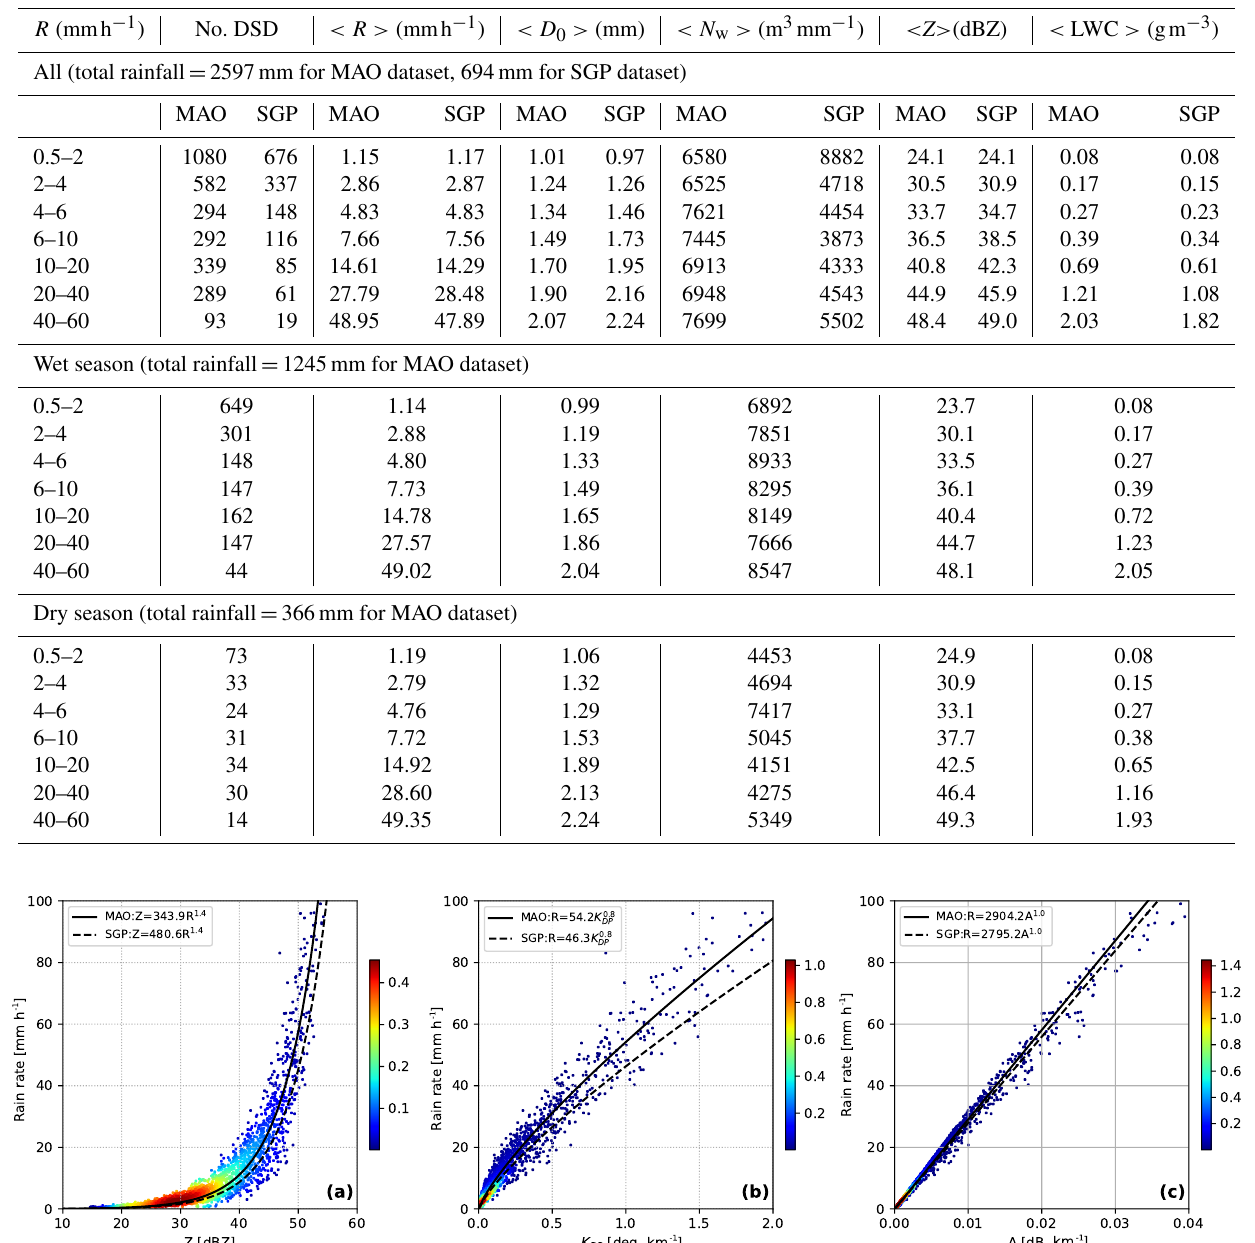
Figure 2. Scatter plots of (a) Z , (b) K DP and (c) A versus rain rate and overlaid associated relationship fits using the least-squares method for the Amazon (MAO, solid lines) and SGP-Oklahoma (SGP, dashed lines) sites, for the S-band wavelength. Density is shown on the color